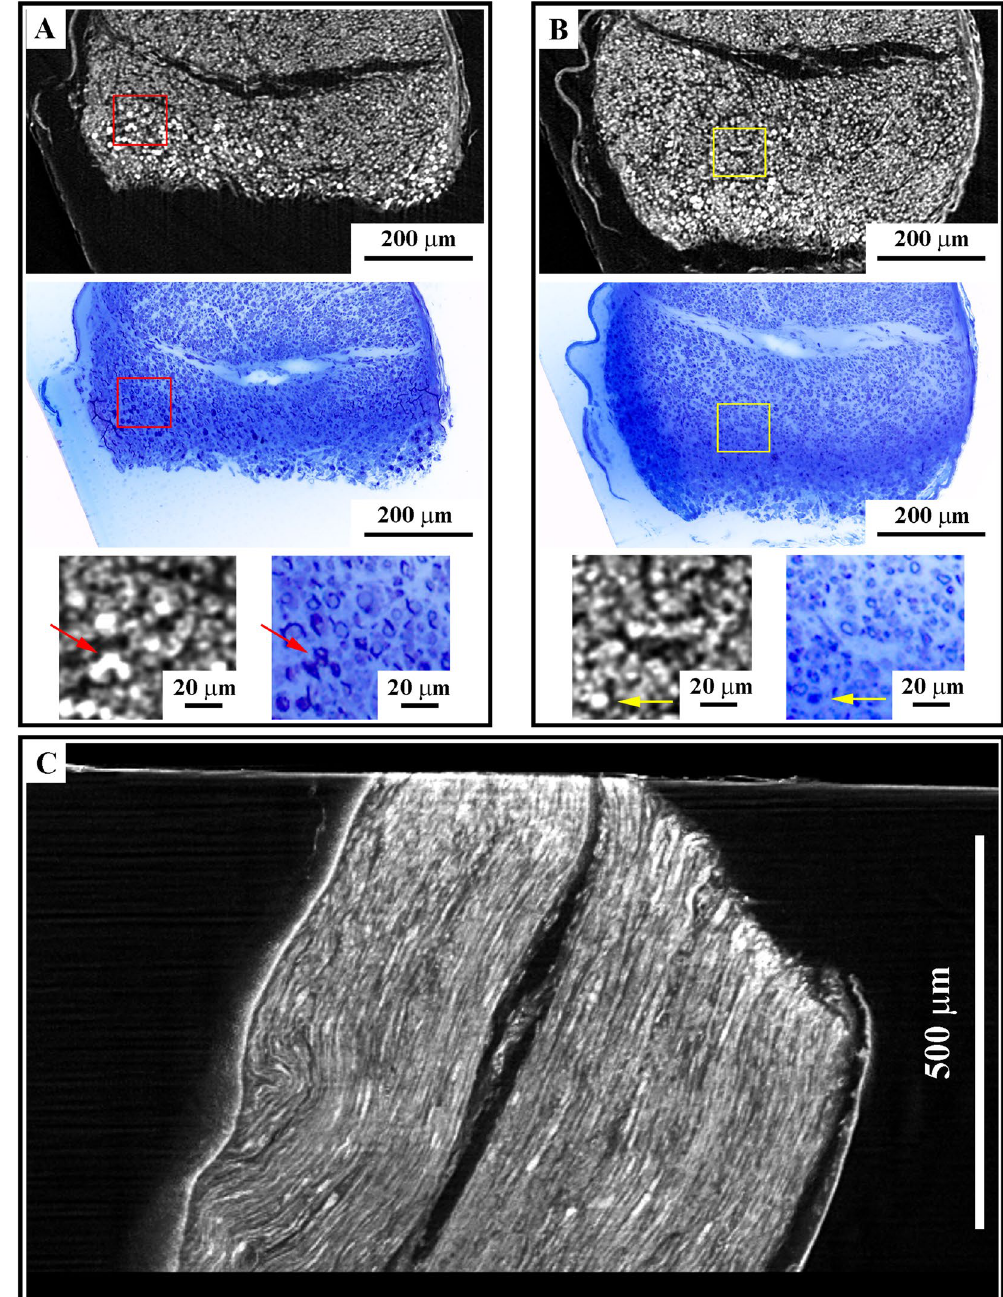
Figure 4. The correlation procedure. ( A ) A representative virtual slice (first row) correlates perfectly with the corresponding optical image (second row). In the bottom row is reported the enlargements of the regions boxed in each virtual and optical section. Arrows indicate some of the correlation points used for the alignments of virtual and optical sections. ( B ) The alignment is preserved at different depths. ( C ) A yz view of the sample in